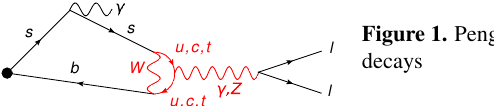
Figure 1. Penguin diagram contributing to B s